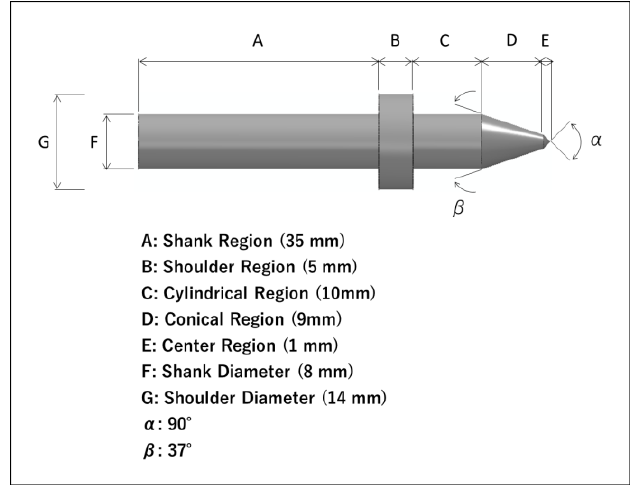
Figure 4. Key dimensions of the tool.